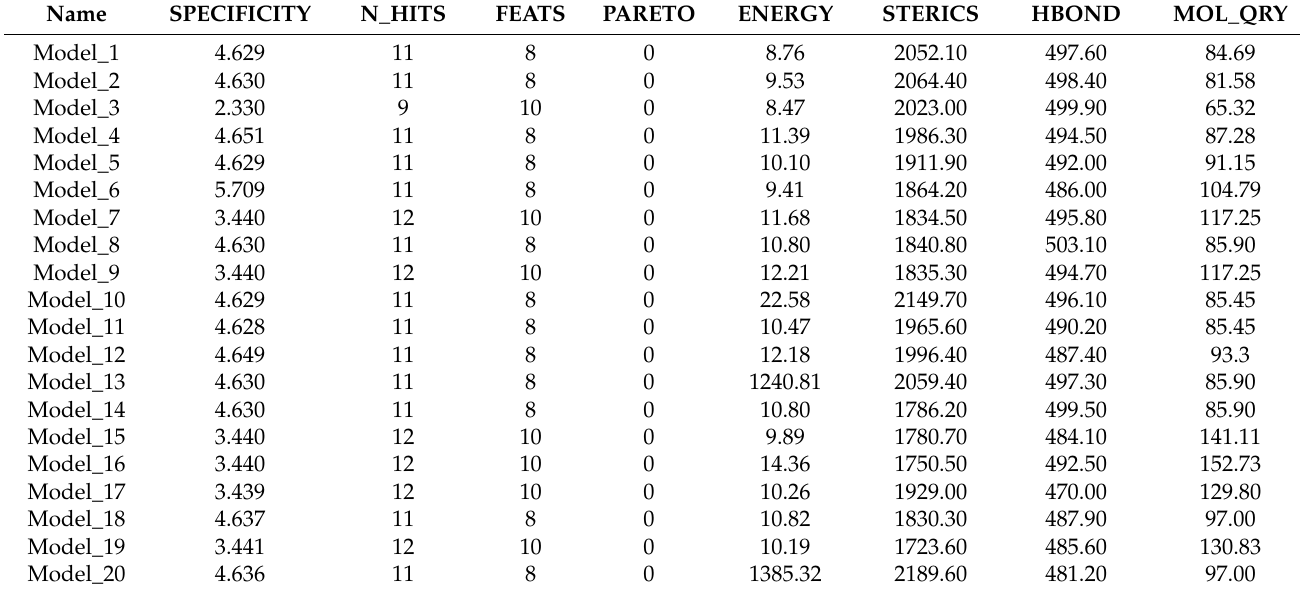
Table 4. Statistical results of the pharmacophore